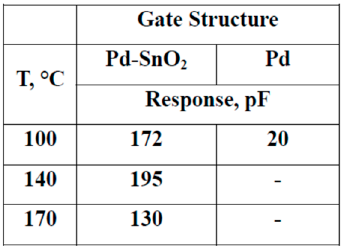
Figure 6. The response of capacity sensors to108 ppb NO 2 concentration at different